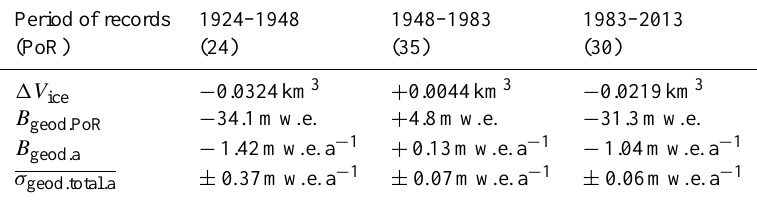
Table 2. Ossoue Glacier volumetric variations ( (cid:49)V ice in km 3 ) and associated cumulative geodetic mass balance B geod.PoR (in mw . e . ) and geodetic mass balance rate B geod.a (in mw . e . a − 1 ). We considered a mean density of d = 850 ± 50kgm − 3 for 1948–1983 and 1983–2001, and 900kgm − 3 otherwise. The term σ geod.total.a refers to the annualized random error.